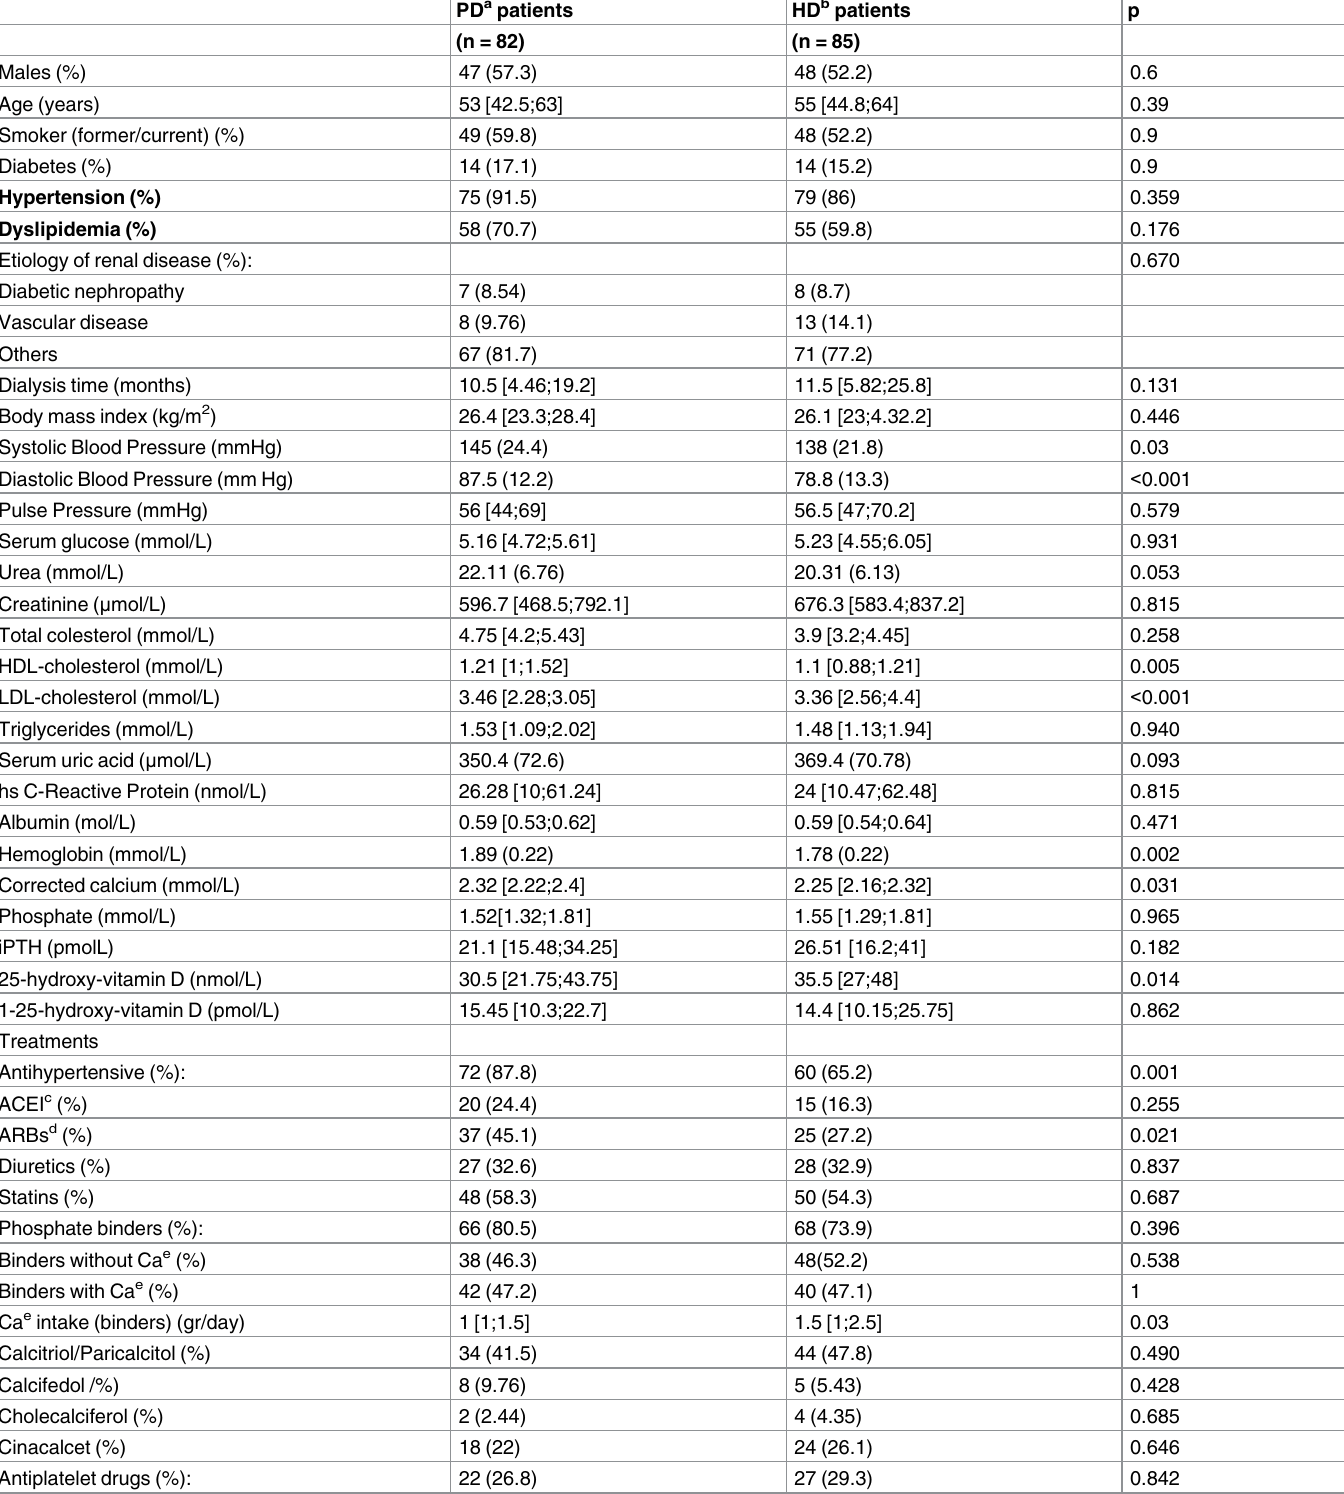
Table 2. Main Baseline characteristics of patients with 2-yearsfollow-up according to dialysis